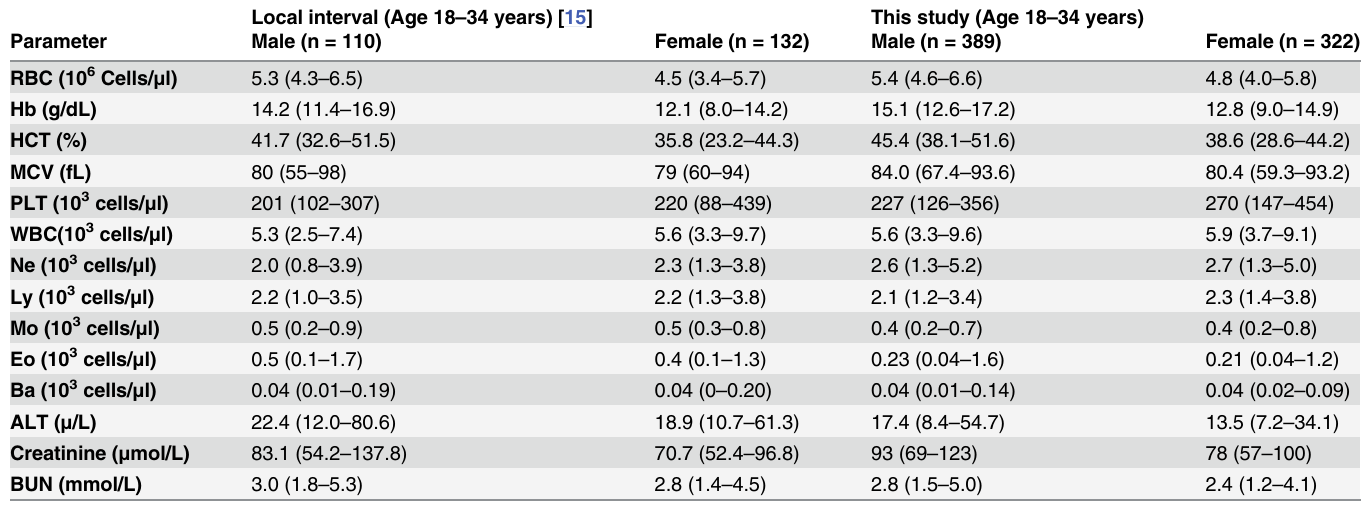
Table 3. Adult hematological and biochemistry reference values (median and 95 th -percentile) comparison between locally-established reference intervals versus reference values from the Kisumu Incidence cohort study in western Kenya (2007 –